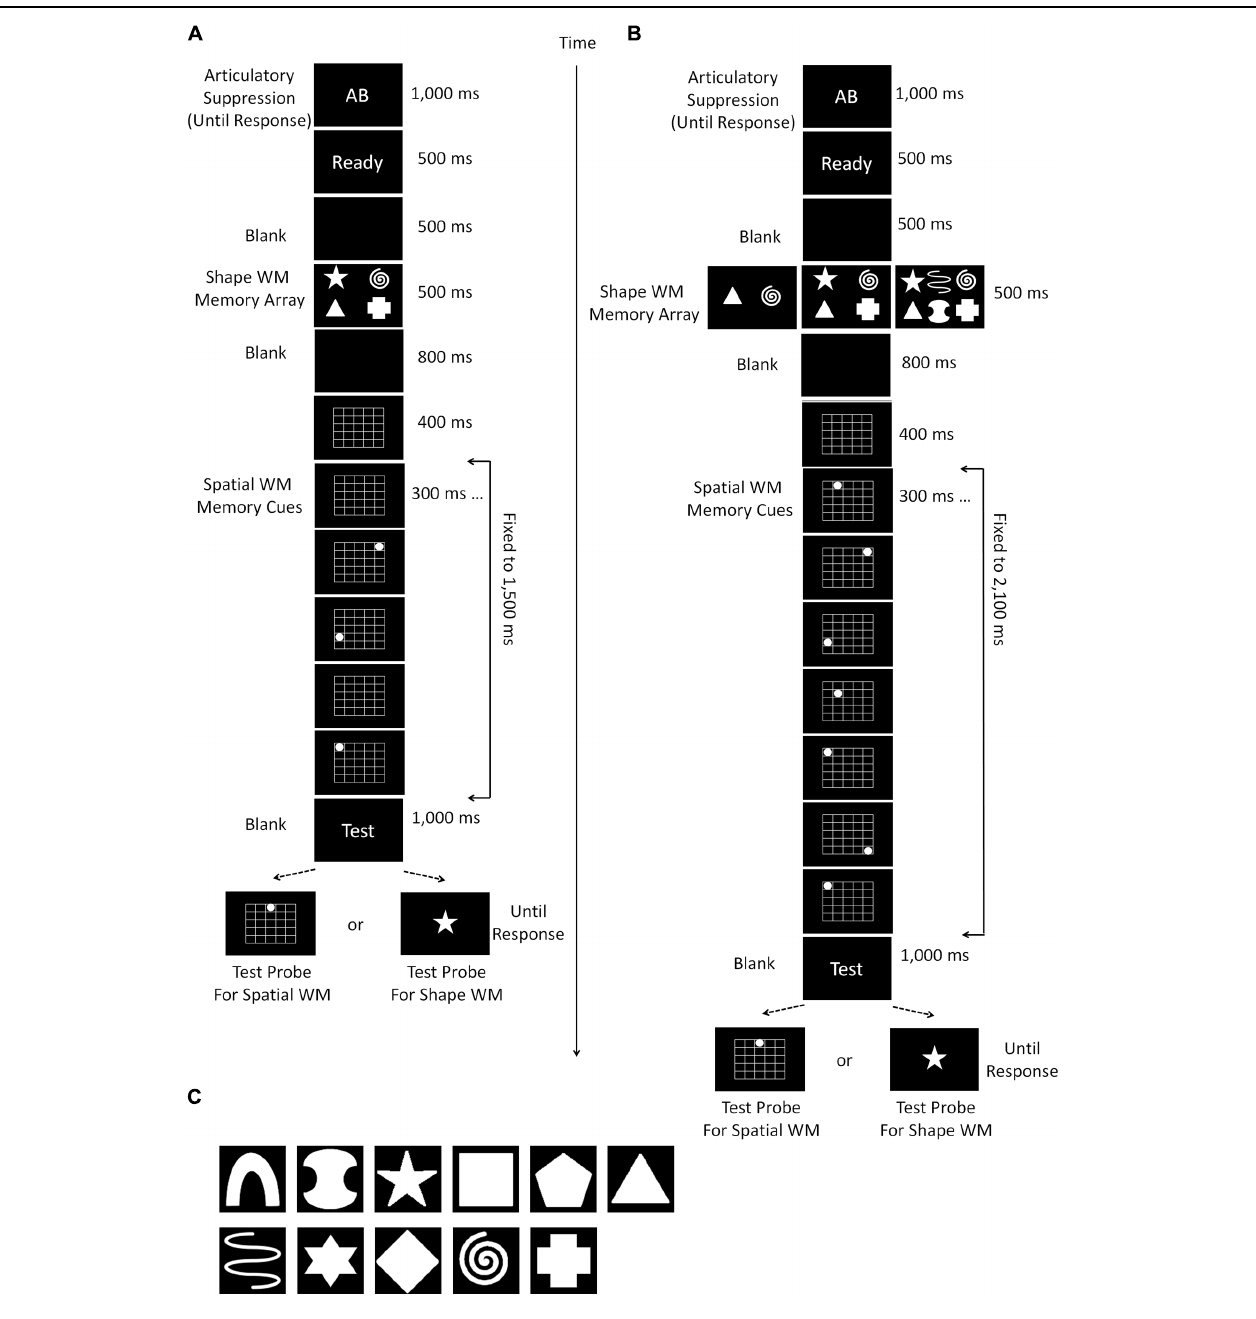
FIGURE 3 | Schematic diagrams of the experimental procedure used in Experiments 2 (A) and 3 (B). Experiment 2 was exactly the same as Experiment 1b except that the task order was reversed. In Experiment 3, the load size of shape WM was manipulated (2, 4, and 6) instead of the spatial WM (fixed to 7). (C) Shows the shape stimuli which were used for the shape WM task in Experiment